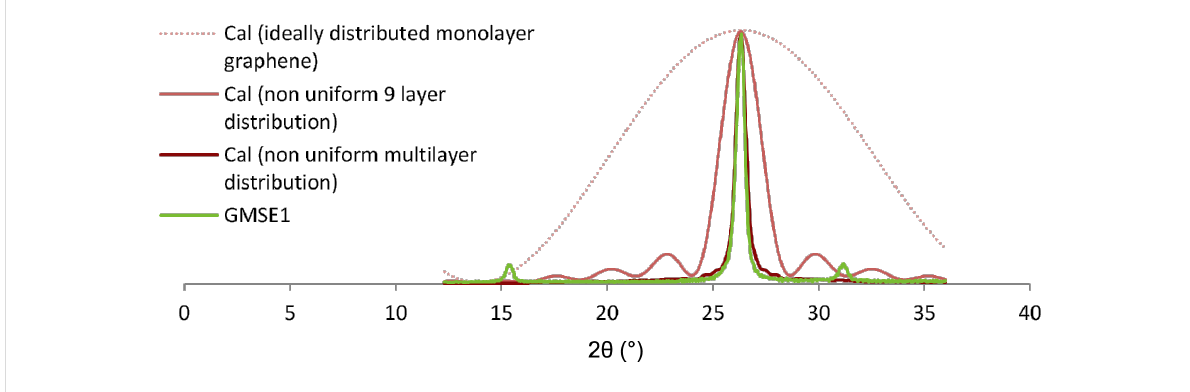
Figure 4: Nonuniform multilayer distribution curves for sample GMSE1 calculated from Equation 1.